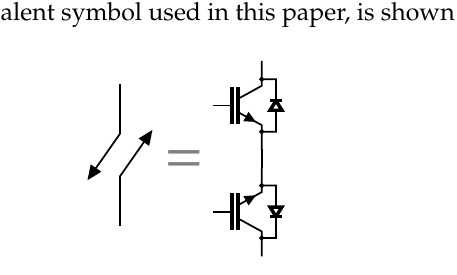
Figure 2. A symbolic equivalent of a four-quadrant switch with emitter connected IGBT